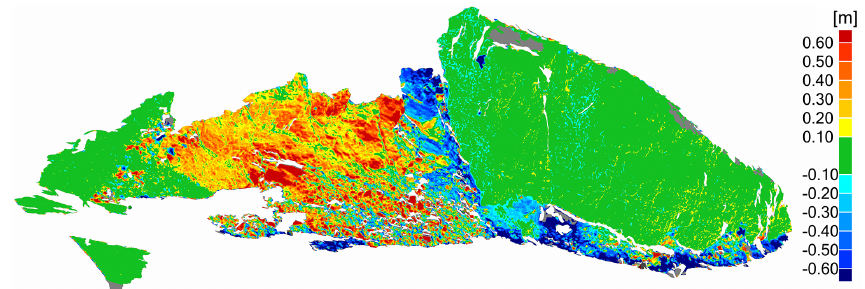
Figure 12. Change map based on the detected stable regions – comparison between the datasets from 2014 and 2015.